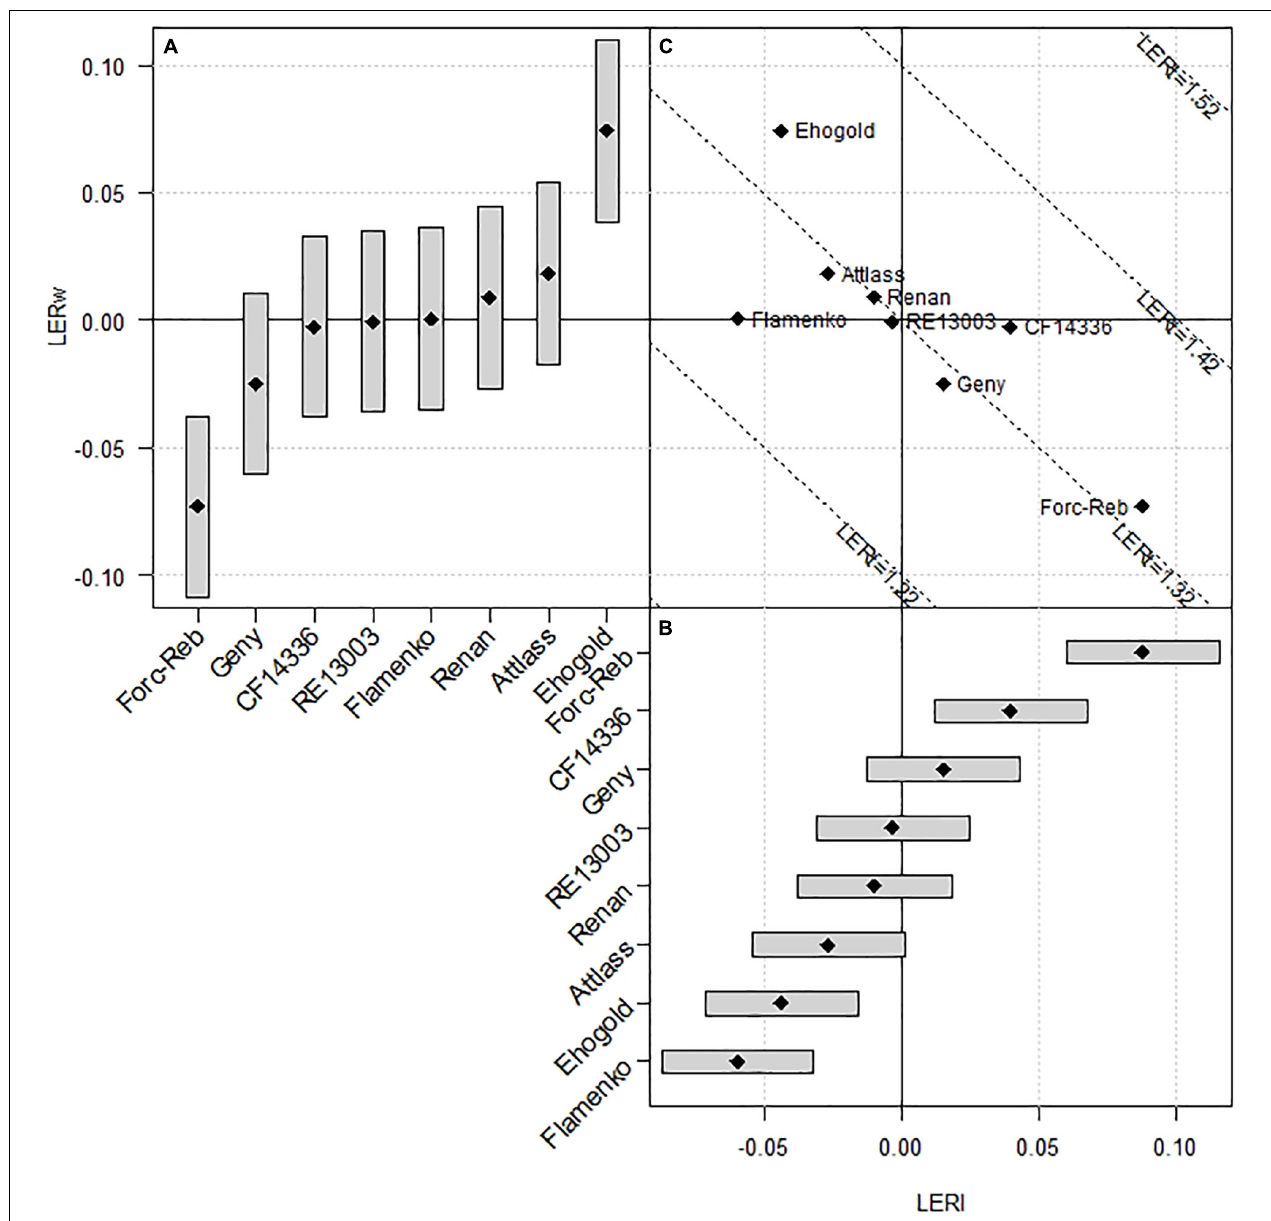
FIGURE 3 | Effects of the 8 wheat genotypes on LERw (Producer effect, graph A ) and LERl (Associate effect, graph B ). The dashed lines in graph (C) have the same total LER (LERt). Average LERt is 1.32 as the sum of average LERw (0.59) and average LERl (0.73).